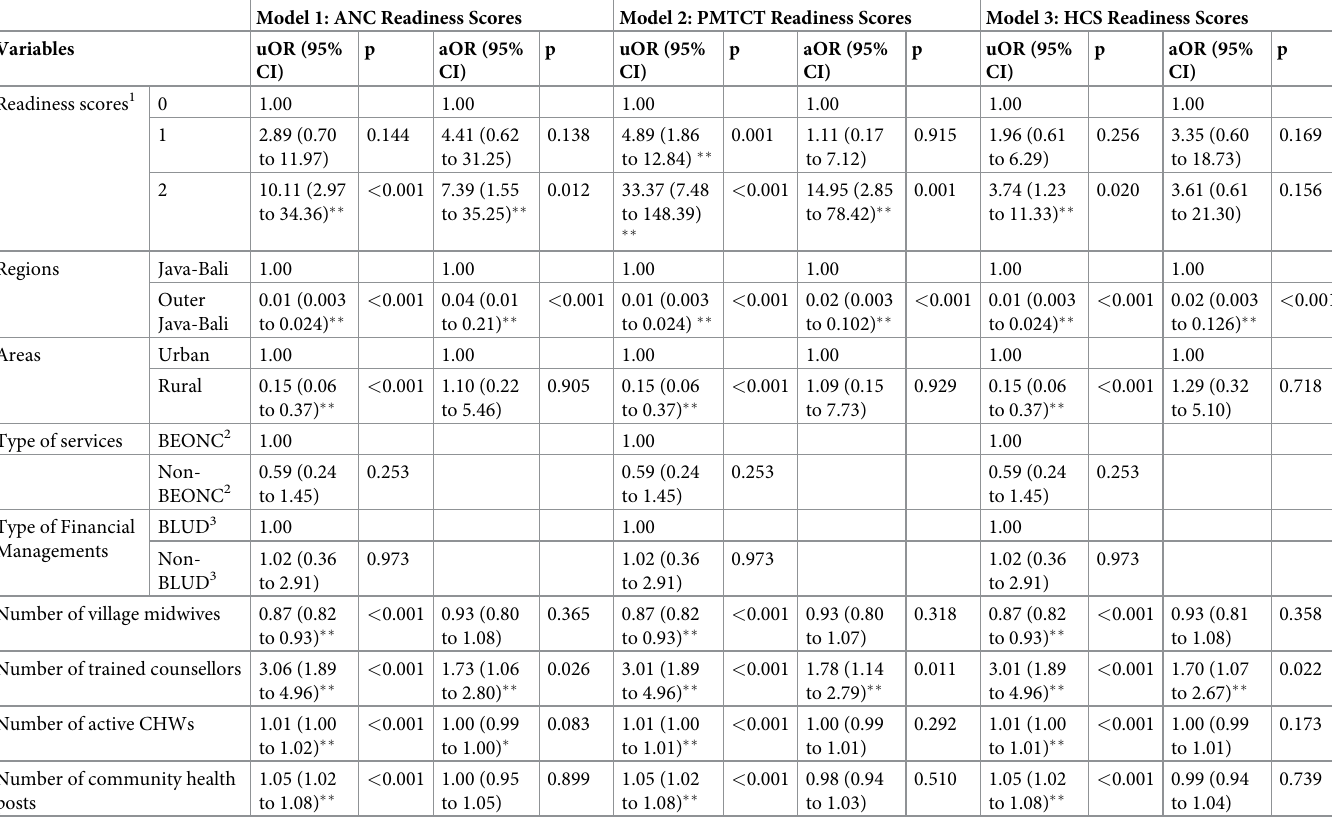
Table 2. Results of multivariate logistic regression model of factors associated with the proportion of � 10% of pregnant women tested for HIV per facility in public facilities, in 2016 in Indonesia. Model 1: ANC Readiness Scores Model 2: PMTCT Readiness Scores Model 3: HCS Readiness